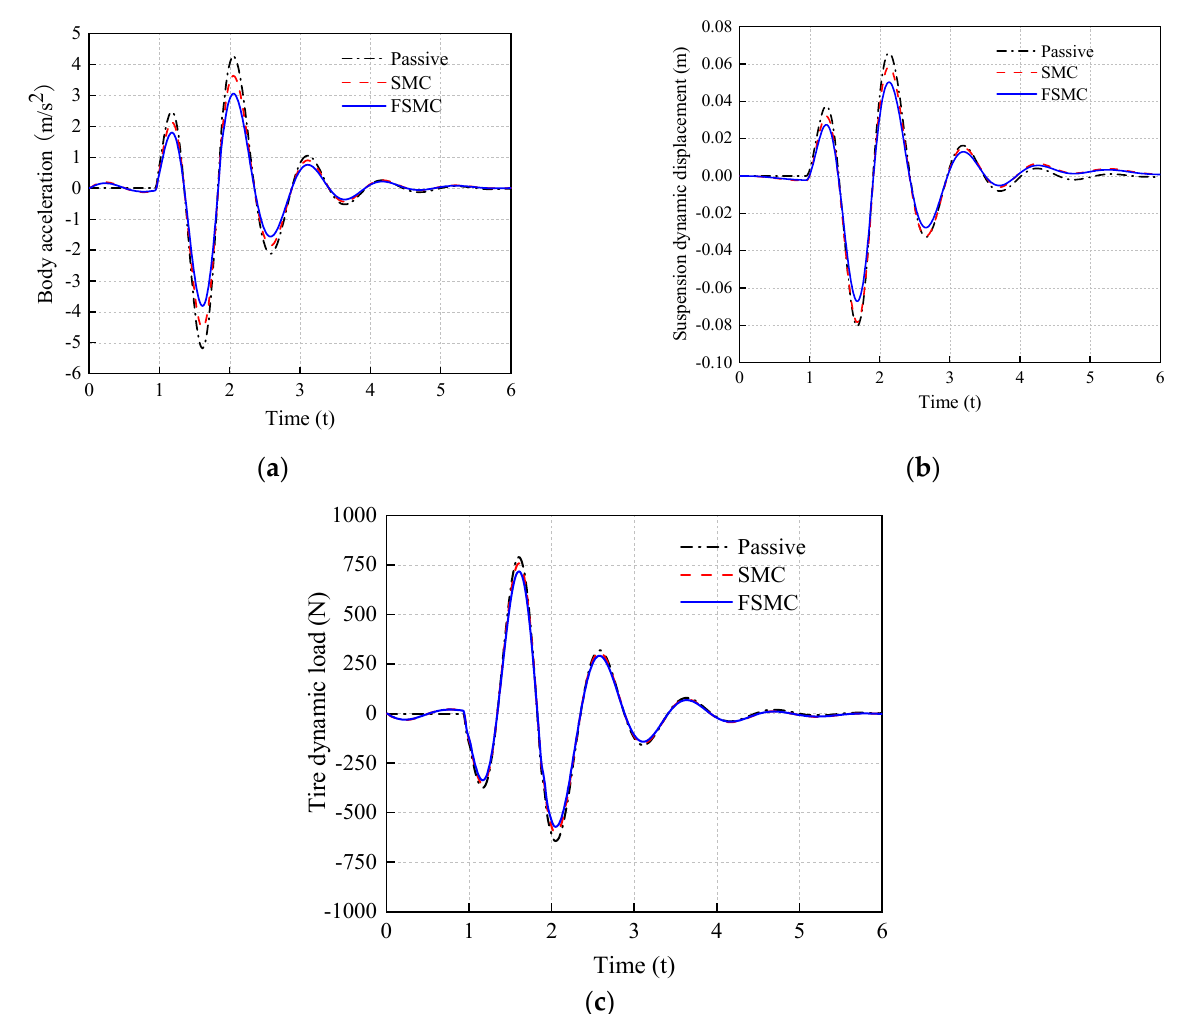
Figure 20. Simulation curve of air suspension system under impact road excitation. ( a ) Body acceleration, ( b ) suspension dynamic displacement, ( c ) tire dynamic load.